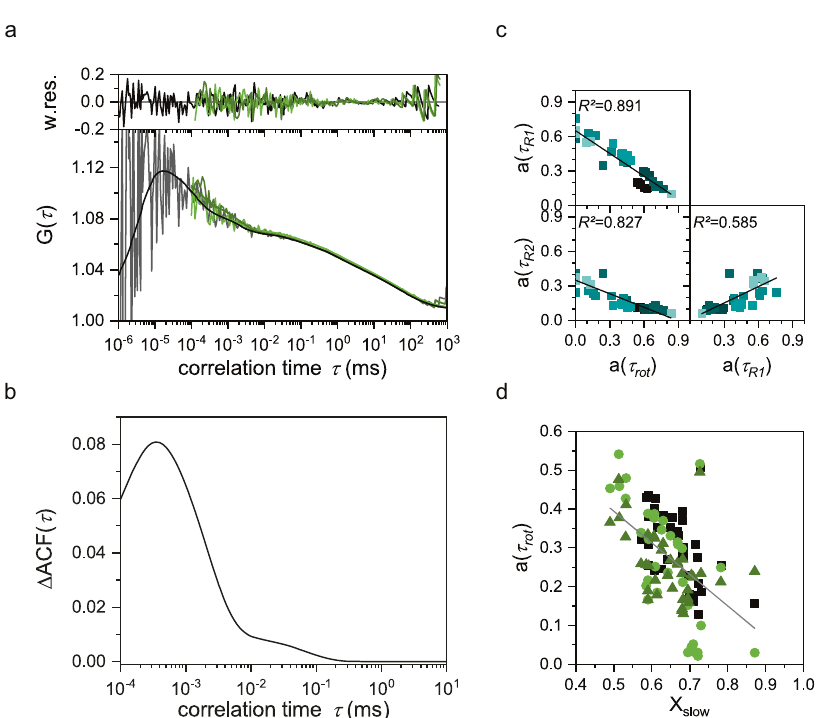
Fig. 4 Continuous wave FCS hints at additional slow rotation. a Exemplary fullFCS measurement from a CHO-K1 cell transfected with N-terminal-EGFP- β 2 -AR. For the data sliced in 5 s pieces a difference in amplitude between the CCF VV-VH (black) and ACF VH (light green) compared ACF VV (green) can be seen. The data was globally fi tted with Eq. (10). Weighted residues are shown on top. b The absolute difference in amplitude between ACF VV and ACF VH calculated from the fi t parameter (Eq. (12)). c For the ACF VH -curves, an increase in amplitude of τ rot leads to decreasing amount of the two τ R in the µ s range. Both τ R1 and τ R2 are positively correlated. Each color represents the measurement from one cell ( n = 7). τ rot = 99 ± 52 ns, τ R1 = 1.90 ± 0.45 µ s, τ = 128 ± 39 µ s. Data are mean ± s.d. d An increased amount of slow, membrane diffusion, x R2 code is same as in ( a ). Results for CCF VV – VH and ACF VV and for the N-terminal-SNAP- β 2 AR conjugated to AF488 are summarized in Supplementary Figs. 16c – f and